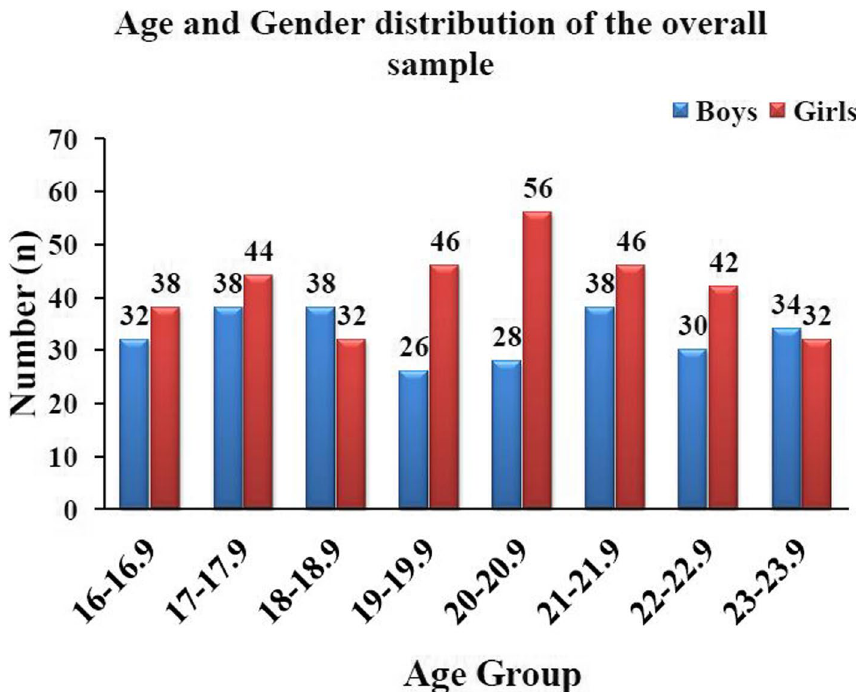
Fig. 1 The overall distribution of included samples according to the sex and age group of the individual